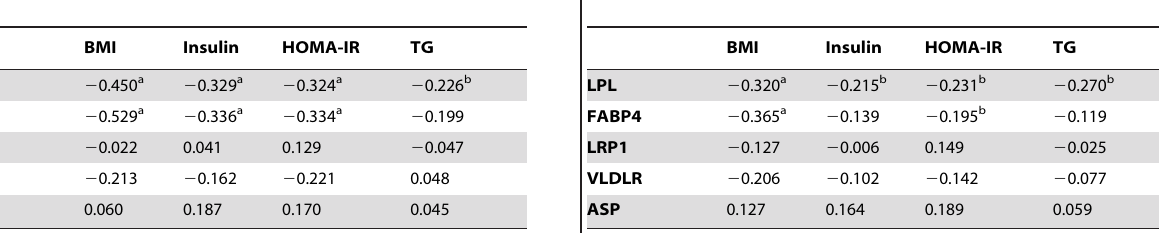
(Table 7). SAT LPL gene expression correlated significantly with Table 4. Correlations between the subcutaneous adipose tissue mRNA expression levels of the genes studied and the BMI, triglycerides, insulin and HOMA-IR in all study